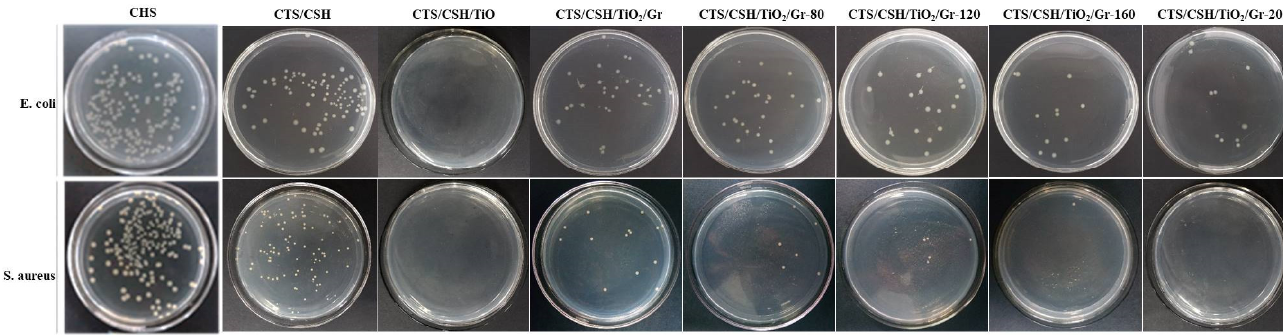
Figure 6. Effect of CSH, CTS/CSH, CTS/CSH/TiO 2 , and different CTS/CSH/TiO 2 /Gr composite membranes on the growth inhibition of E. coli and S. aureus for 24 h after incubation at 37 °C. Table 6. Effects of the CTS/CSH, CTS/CSH/TiO 2 , and CTS/CSH/TiO 2 /Gr composite films (TiO 2 :Gr = 6:4) on the growth inhibition rates (%) of E. coli and S. aureus .